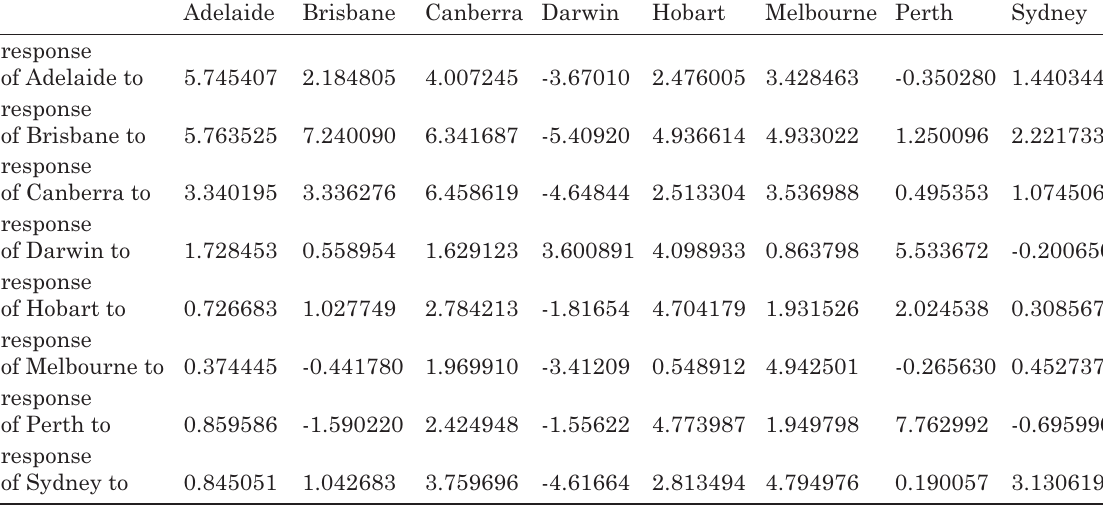
Table 4. Total impulse responses of Australian eight cities’